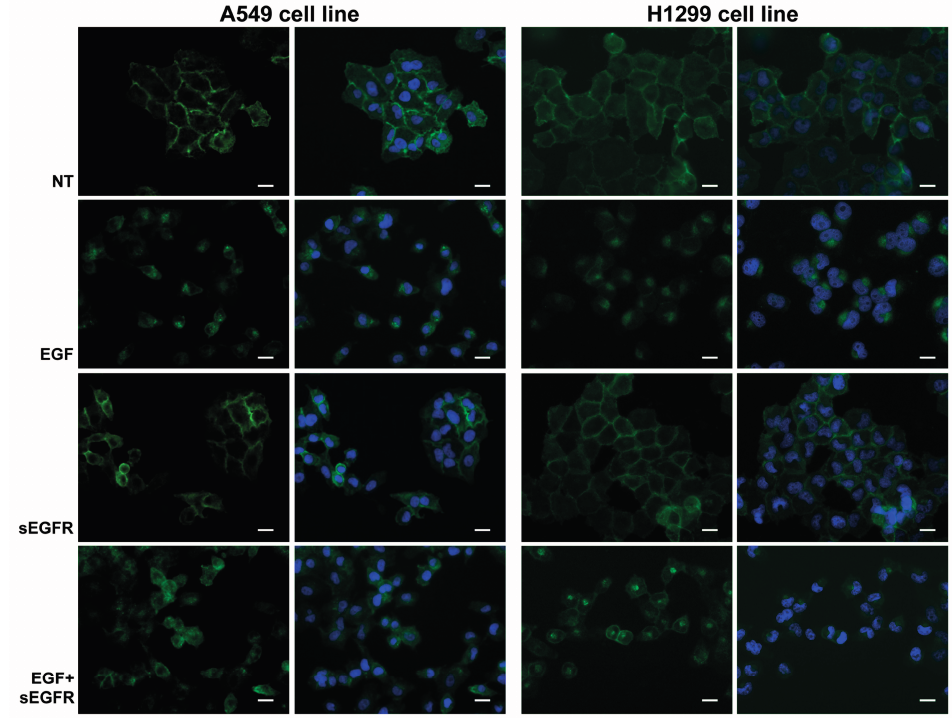
Figure 4. EGFR holoreceptor localization in lung tumor cells treated with sEGFR/EGF proteins. A549 and H1299 cell lines were untreated (NT) or treated with sEGFR (1 µg/mL) and EGF (100 ng/mL), alone and in combination (EGF + sEGFR), and EGFR holoreceptor localization was detected by using an immunofluorescent (IF) assay 24 h after treatment. Cells were treated with a polyclonal antibody against EGFR-ECD (Ab1_EGFR) and stained with FITC-conjugated anti-mouse secondary antibody (green). Cell nuclei were stained with DAPI (blue). Magnification: 40×. Scale bar: 20